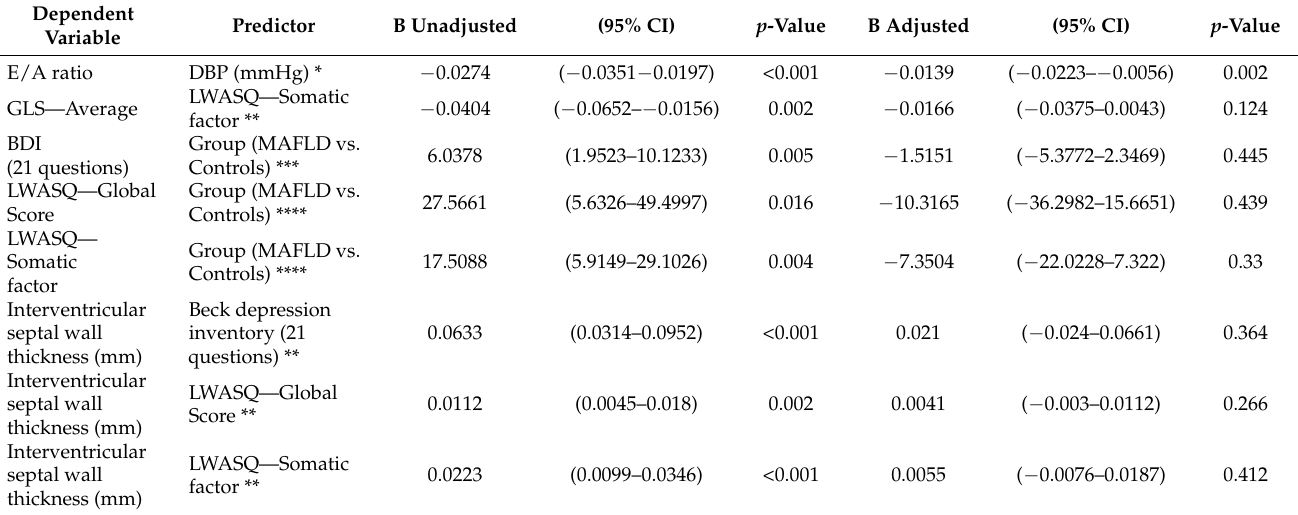
Table 5. Univariate and multivariate linear regression models predicting DBP (mmHg), Group (MAFLD vs. Controls), Beck depression inventory (21 questions), ASQ—global score, and ASQ— somatic assessment, using several dependent